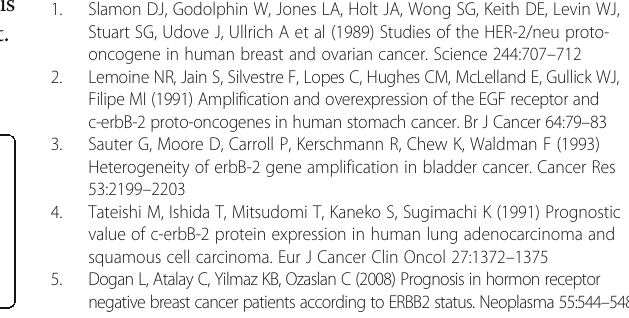
5 mm. Table S1. Relative intensities of in vivo MR images measured from figure 5 and S4 (red solid-lined ROI) (DOCX 1110